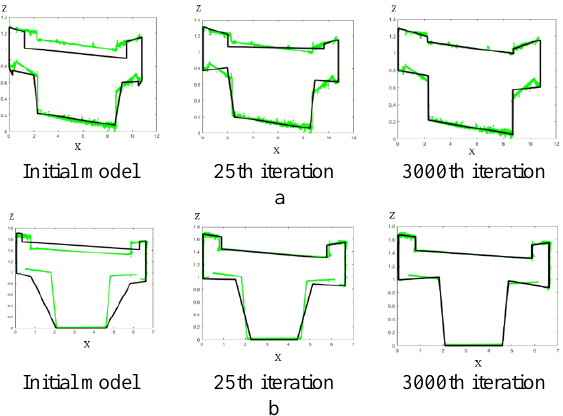
Figure 13. Fitting 2D models for: a: bridge 1; and b: bridge 2.